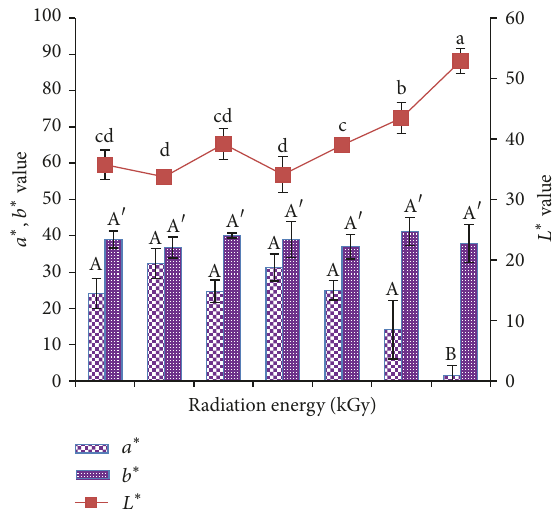
Figure 1: Effect of irradiation on color of SBJ. 𝐿 ∗ represents light- ness; positive 𝑎 ∗ value represents red; positive 𝑏 ∗ value represents yellow. Values are represented as mean ± SD. Significance was tested by Duncan Multiple Range Test at 𝑃 < 0.05 , and values with the same superscript were found not significantly different from each